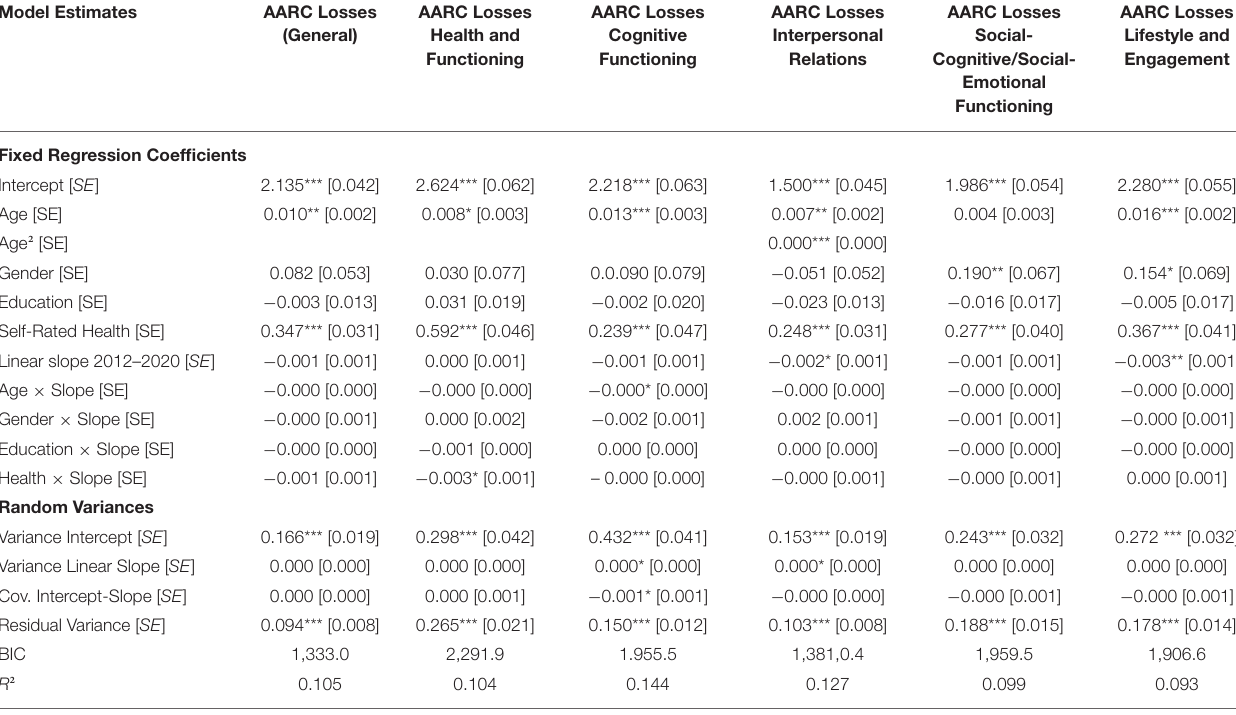
TABLE 2 | Longitudinal multilevel regression models of changes in AARC